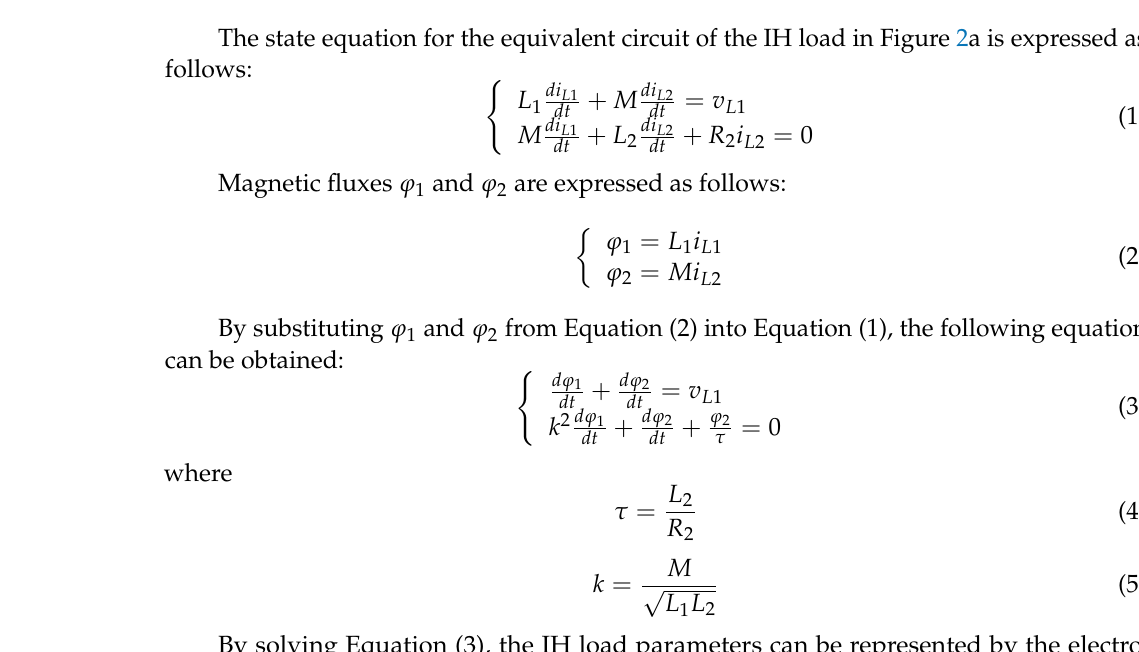
Figure 2. Transformer circuit model for IH fixed roller. ( a ) Transformer model. ( b ) Transformer equivalent circuit model . ( c ) L-R series equivalent circuit model .